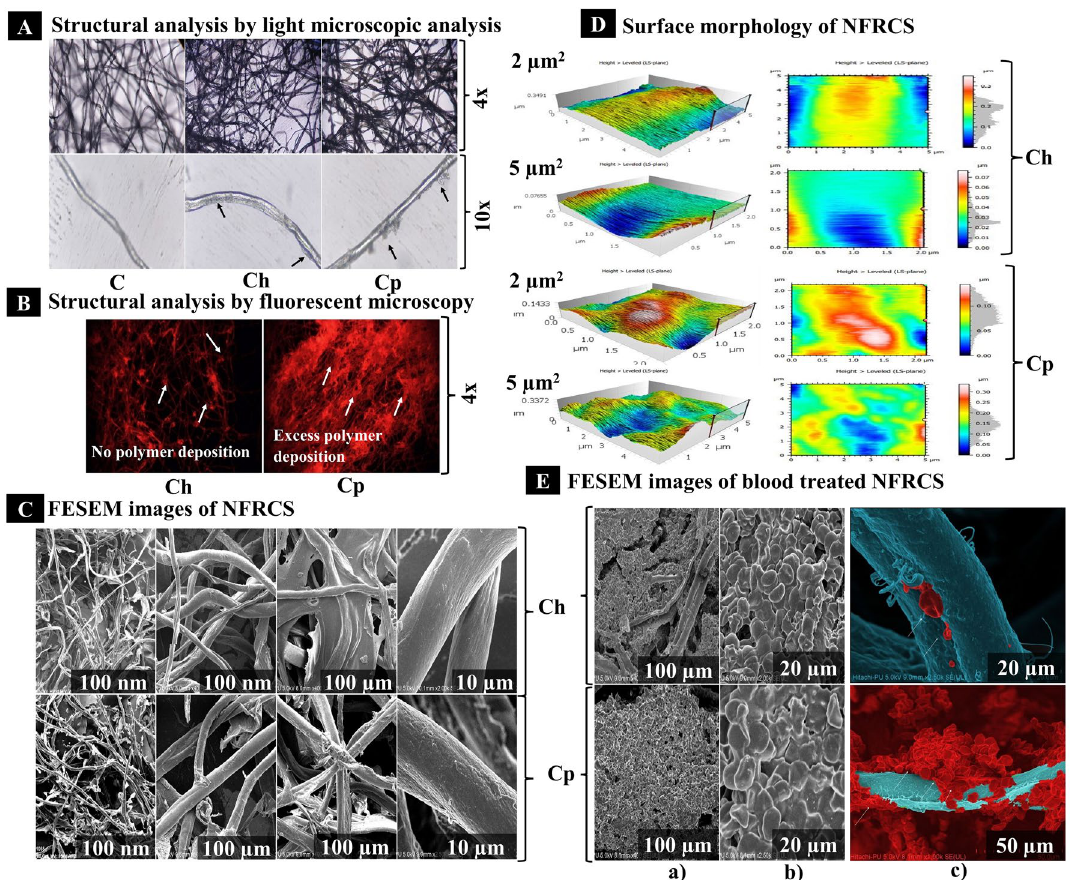
Figure 4. The structural analysis of Ch NFRCS and Cp NFRCS by variuos techniques. ( A ) Represents t he HFFC deposition on the surface of the Ct and excess polymer deposition in the network of fibers interconnection (micrograph captured at 4 × and 10x). ( B ) The microscopic images (4x) represent the HFFC disposition in the network of Ct by using a fluorescent microscope. ( C ) The FESEM images show the Ct fiber’s interconnection, film formation among the Ct fibers, and uniform surface coating on the surface of Ct fibers. ( D ) represents the surface morphology (surface roughness) of Ch NFRCS and Cp NFRCS at 2 µm and 5 µm height using AFM. 3D images were reconstructed using MountainsLab® Premium 8.2.9526 (https:// www. digit alsurf. com/ suppo rt/ softw are- updat es/), and at 2 µm height, Ch showed better surface smoothness than Cp NFRCS. ( E ) The FESEM images show the blood clot formation on the surface of NFRCS, intactness of the RBC clot, clot formation on the surface of Ct at submicron level, and formation of polyhedrocytes confirm the intactness of the clot in the presence of Cp